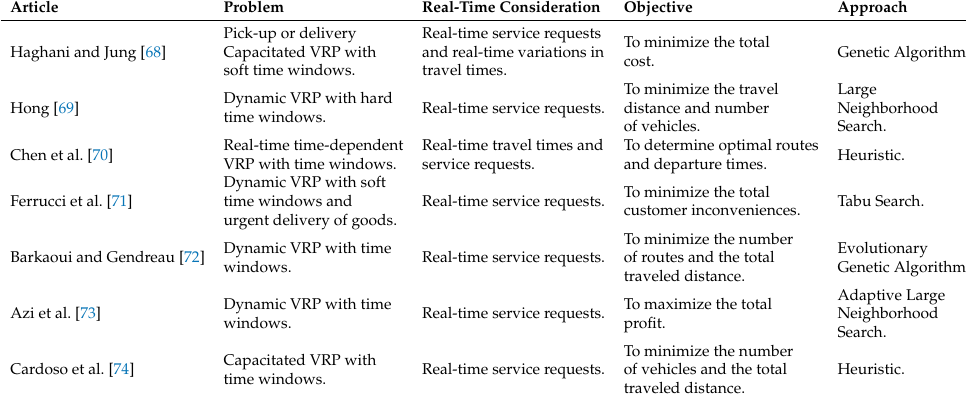
Table 1. Approaches to solving VRPs with real-time constraints in the